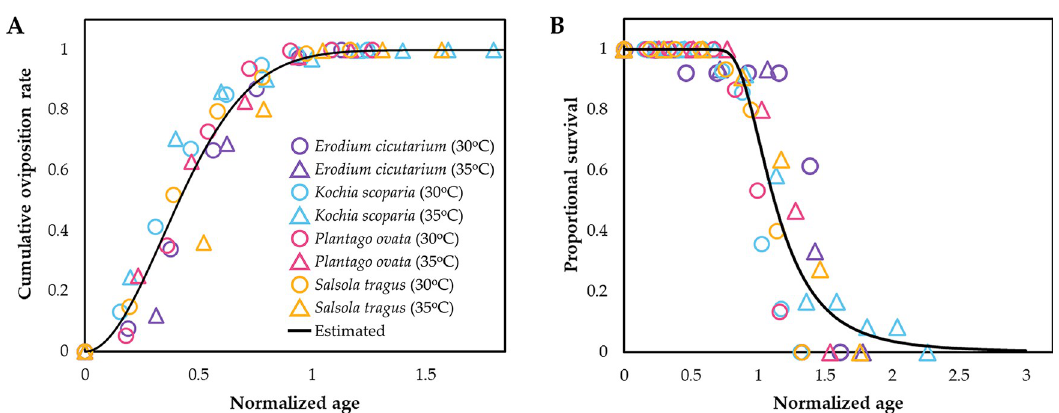
Fig 3. Age-specific (A) cumulative oviposition rate and (B) survival models of female beet leafhoppers on four non-agricultural host plant species at two temperature conditions.